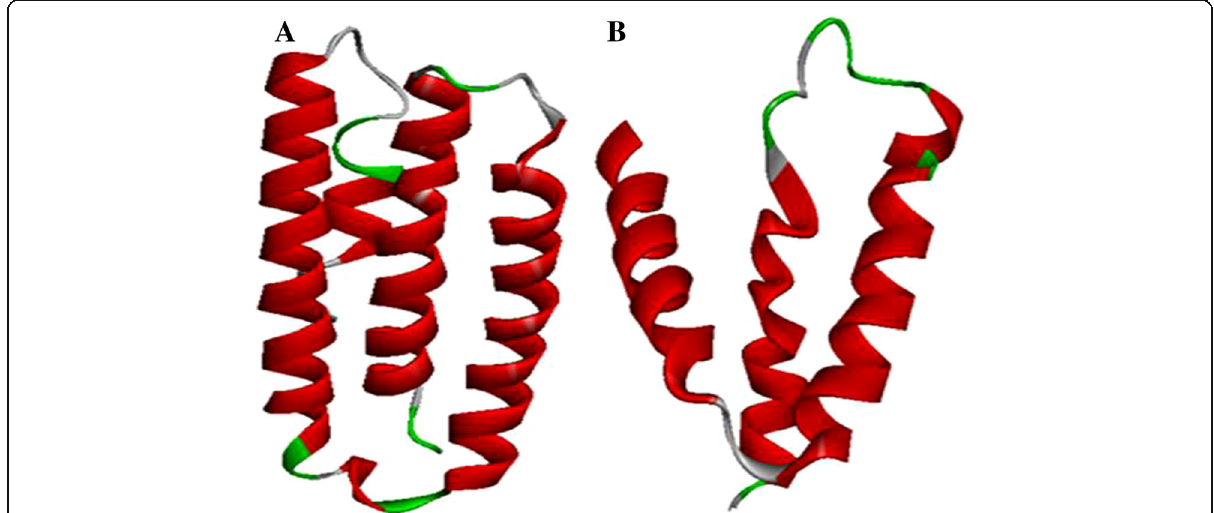
Fig. 5 Structure modeled by ab initio CRM1-binding domain of the NEP of both A/equine/Miami/1/1963 (H3N8) reference strain ( a ) and A/ equine/Nador/1/1997 (H3N8) ( b ). These two structural models well illustrate the effect of mutations resulting in a V-modification of the three- dimensional structure of the CRM1 domain of NEP of A/equine/Nador/1/1997 strain